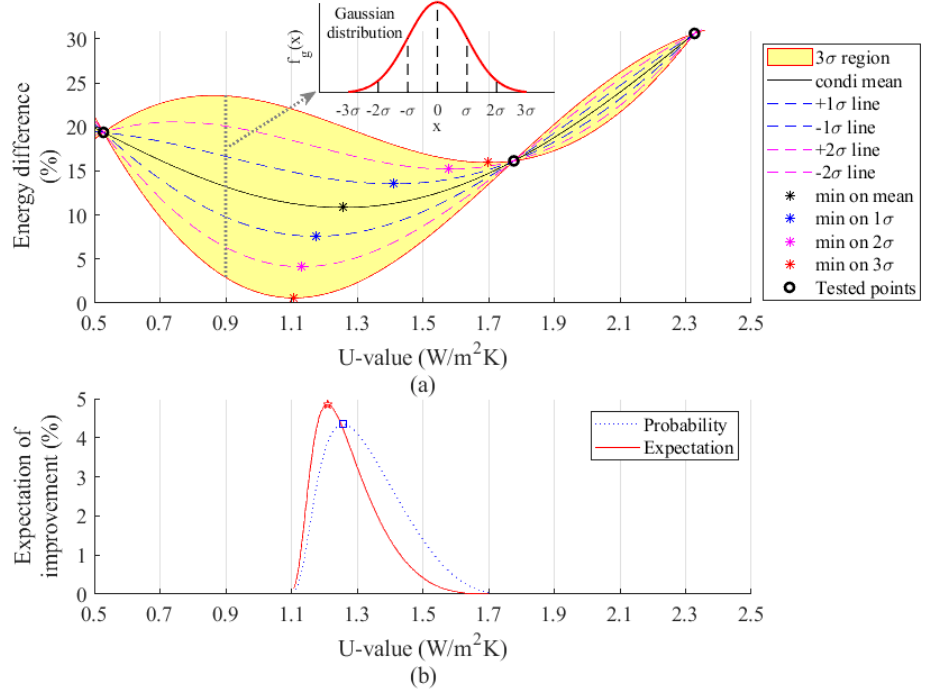
Figure 4. The process of emulator for model parameter calibration. ( a ) Emulator’s process with Gaussian distribution; ( b ) the probability density function and expectation of improvement.